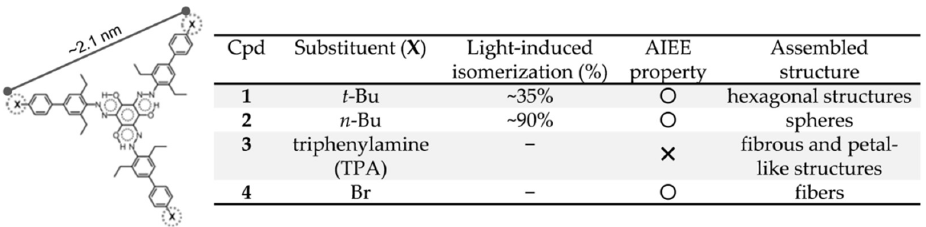
Figure 1. Left: Chemical structure. Right: Substituent effect on light-induced conformation changes, AIEE characteristics, and morphologies of assembled structures (Supplementary Materials, Figures S1 and S2).